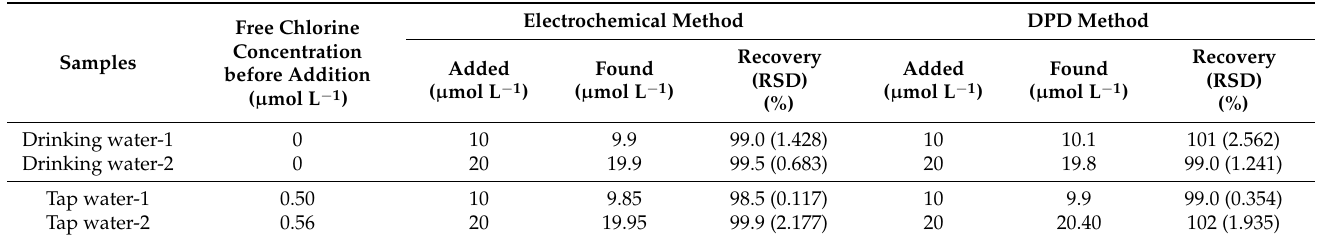
Table 2. Determination of free chlorine in drinking and tap water samples using the p-CFA@ERGO/ GC-modified electrode (the values were obtained from five samples ( n = 5) for each